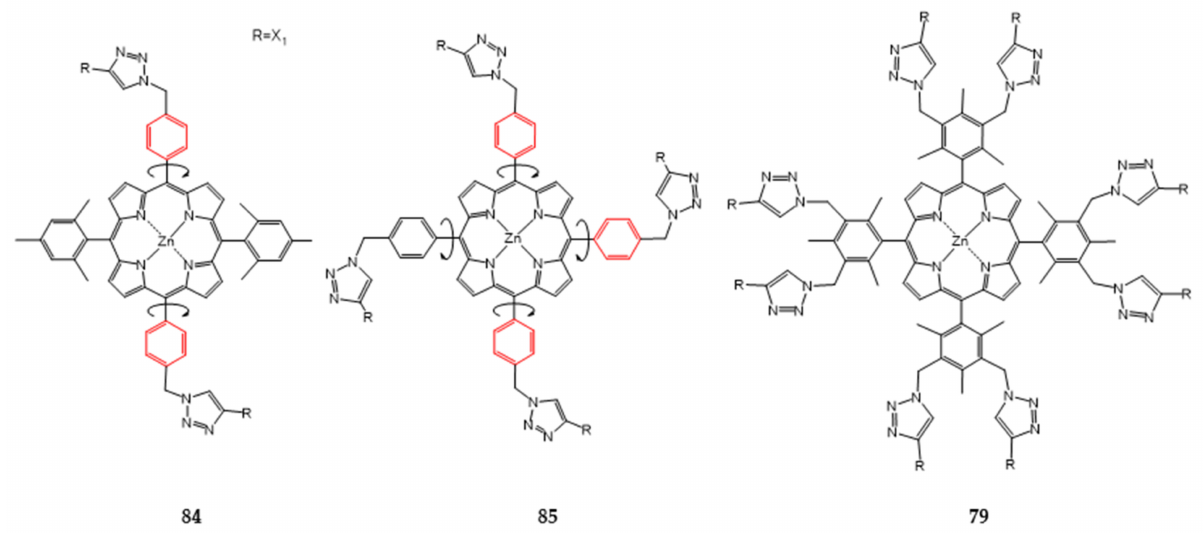
Figure 20. Dependence of stability constants of porphyrinates 79 , 84 – 86 with Py, TrA, and DABCO on the porphyrinate and ligand nature.